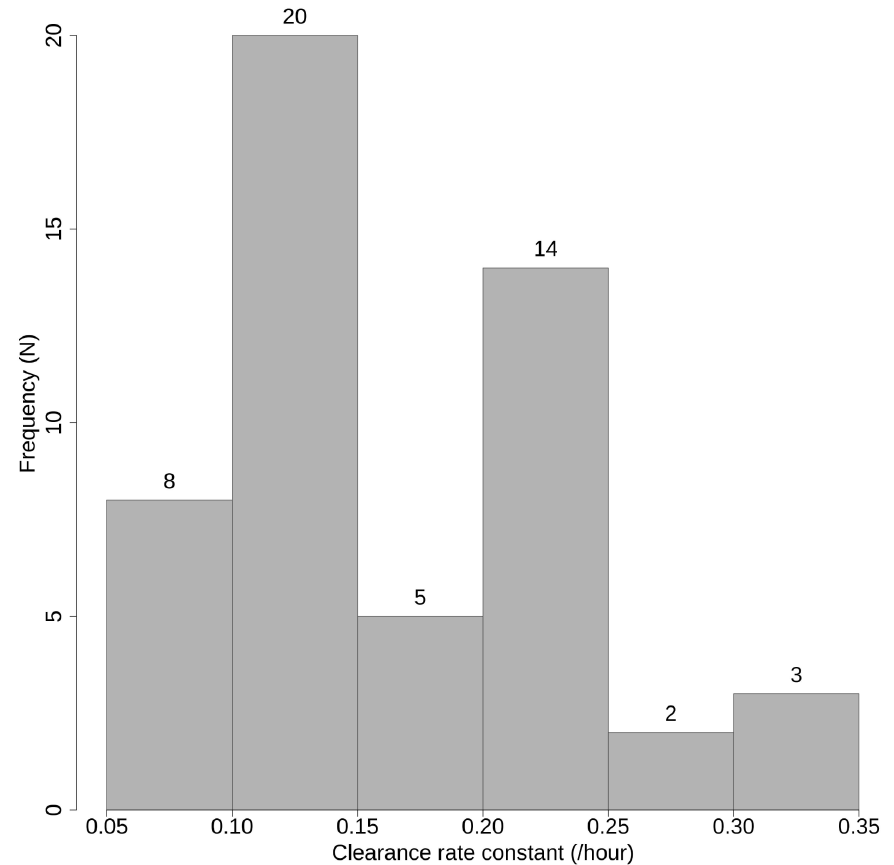
Figure 5. Frequency distribution of parasite clearance half-life.